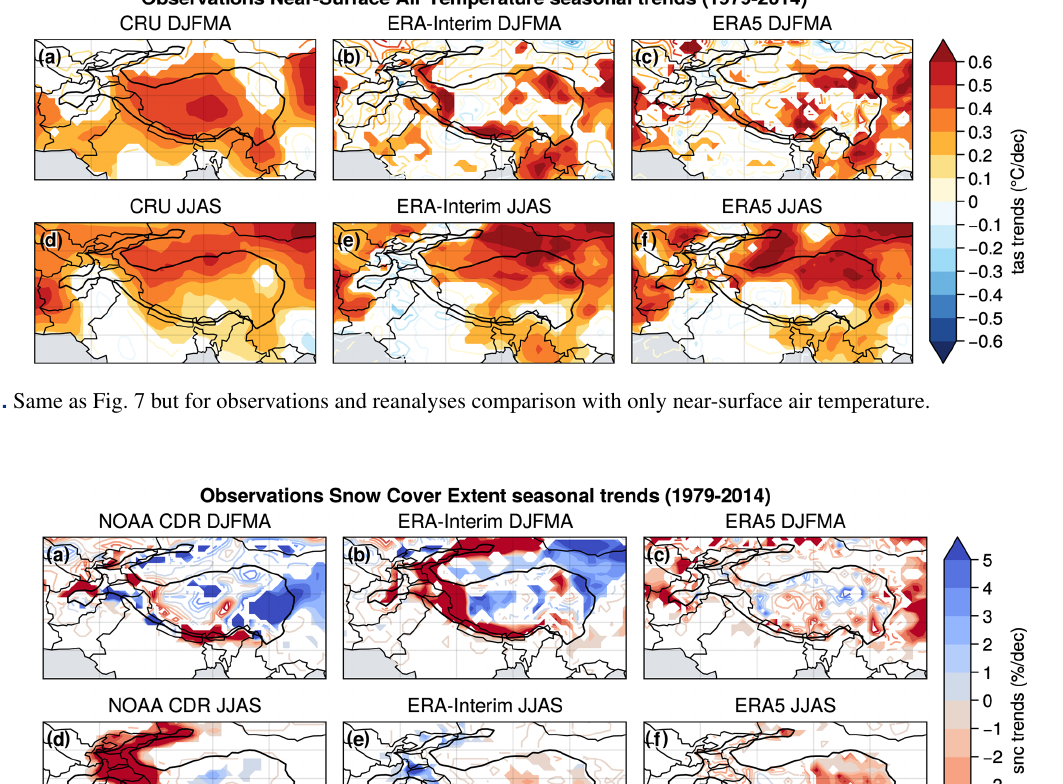
https://doi.org/10.5194/esd-12-1061-2021 Earth Syst. Dynam., 12, 1061–1098,